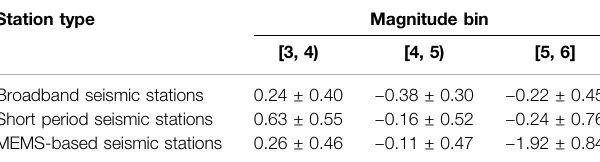
TABLE 3 | Median and standard deviation of the uncertainty on magnitude estimation for each type of station, computed in different magnitude